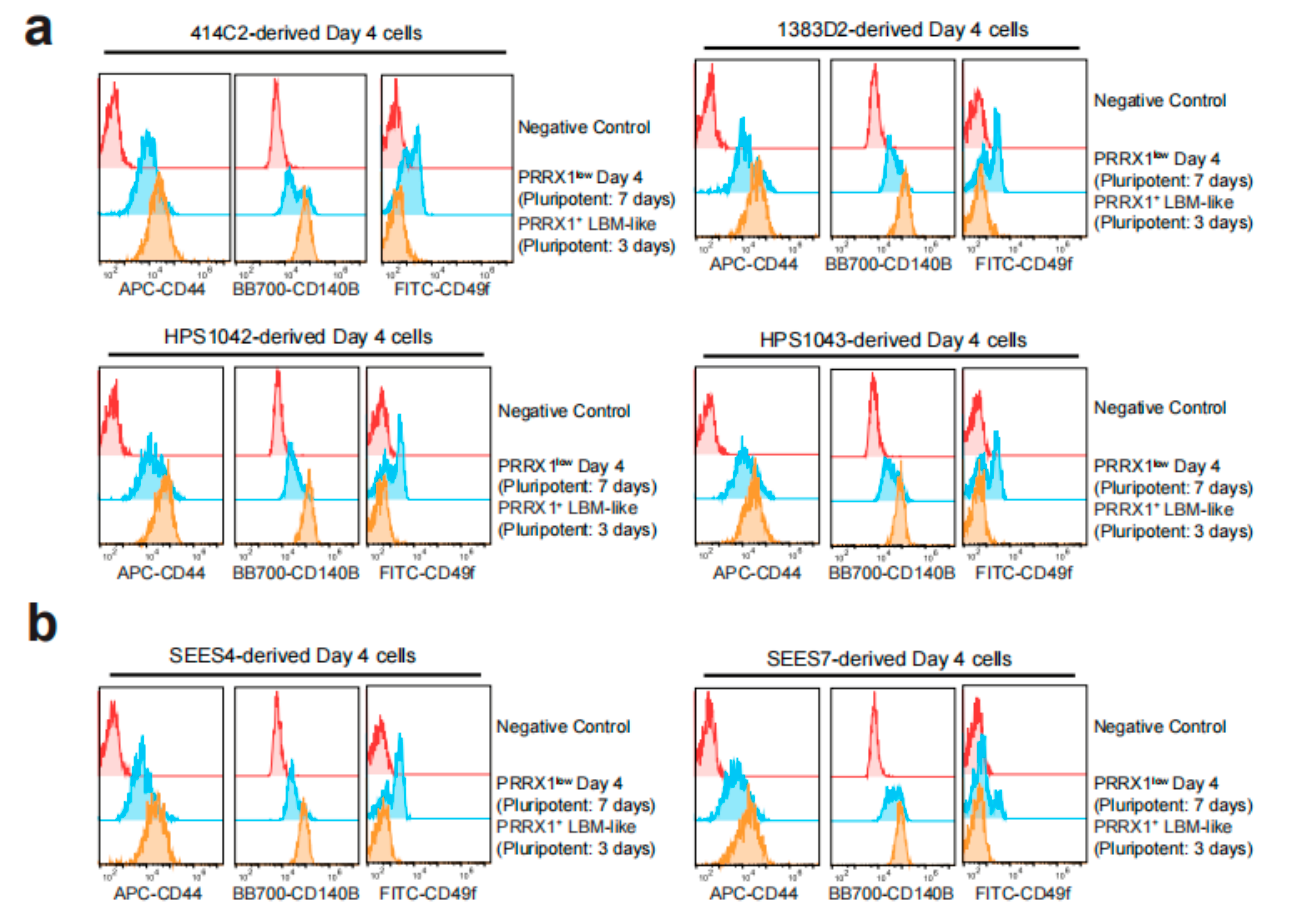
Figure 3. Flow cytometry analysis for comparing the surface levels of CD44, CD140B, and CD49f between hiPSC or hESC-derived PRRX1 + LBM-like cells and PRRX1 low Day 4 cells. ( a ) Representative flow cytometry analysis data for CD44 (HCAM), CD140B (PDGFRB), and CD49f (ITGA6) expressed by hiPSC (414C2, 1383D2, HPS1042, and HPS1043)-derived LBM-like cells or PRRX1 low Day 4 cells. ( b ) Representative flow cytometry analysis data for CD44 (HCAM), CD140B (PDGFRB), and CD49f (ITGA6) expressed by hESC (SEES4 and SEES7)-derived LBM-like cells or PRRX1 low Day 4 cells. 2.4. Detection of CD44 high CD140B high CD49f − LBM-like Cells Derived from hESC